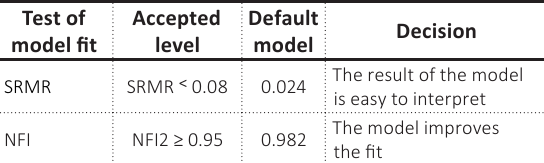
Table 2. Descriptive statistics of the variables Table 3. Testing of model goodness-of-fit Source: Data processed for 2019 .